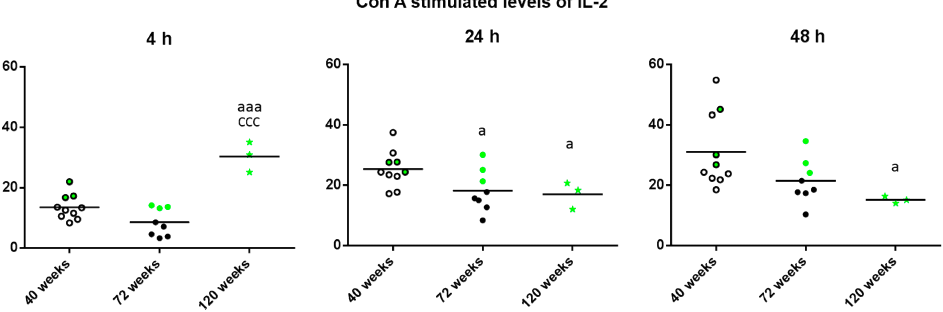
Figure 2. Levels (pg/mL) of IL-2 releases by peritoneal leukocytes from adult (40 weeks), old (72 weeks) and long-lived (120 weeks) mice, after 4, 24 and 48 h of culture in presence of Con A (1 µ g/mL). The green points represent the values in mice that reached 120 weeks. a: p < 0.05; aaa: p < 0.001 with respect to the value in adult mice. ccc: p < 0.001 with respect to the value in old mice.